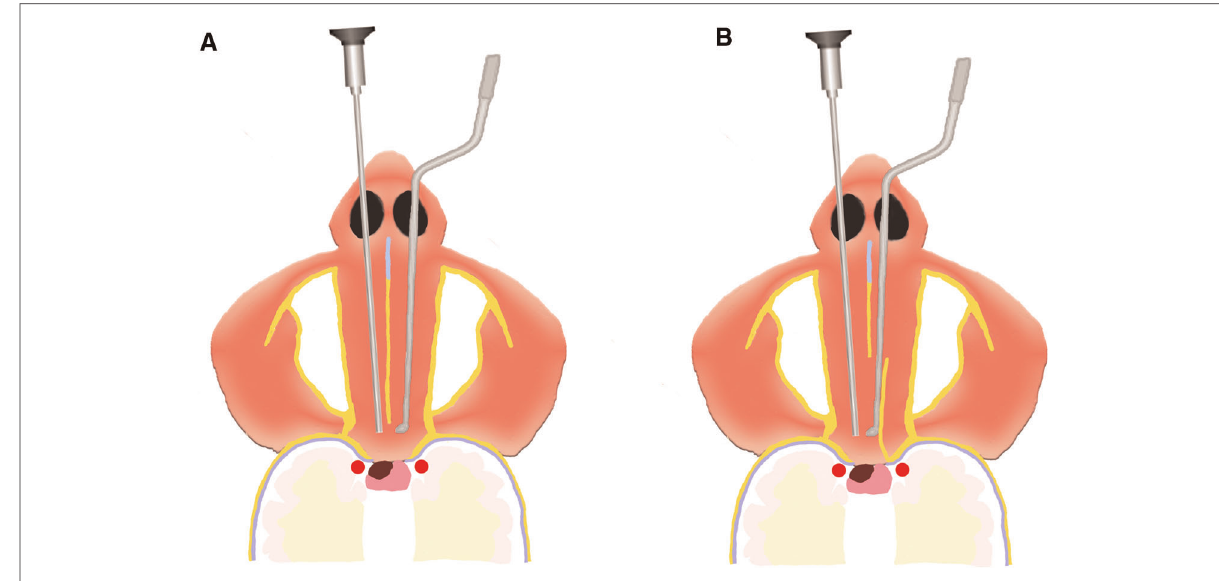
FIGURE 2 The difference between the OETA and BETA. ( A ) For BETA: a part of bilateral posterior septal mucosa was necessarily resected. ( B ) For OETA, the left mucosa of the posterior nasal septum was intact. As to the left nasal septal mucosa, only a 2 cm vertical incision was needed at the anterior level of the middle